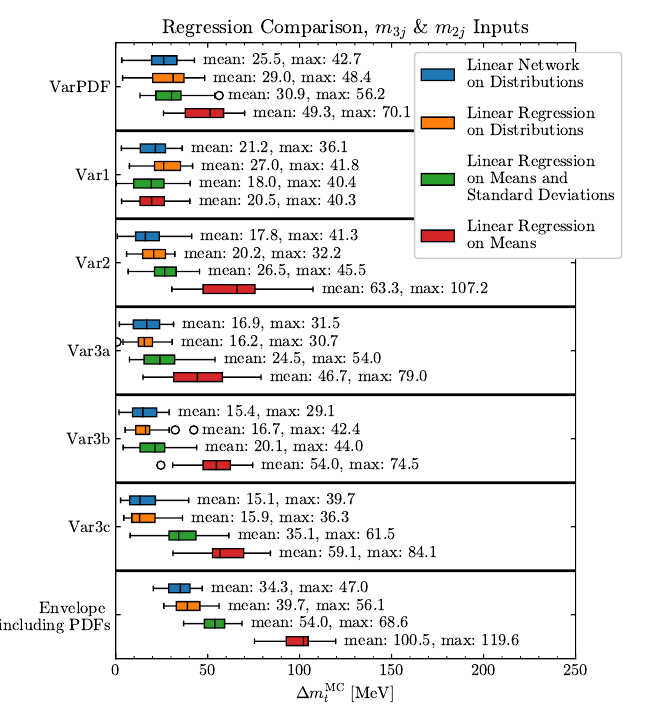
Figure 9. Uncertainties on the top mass fit within each group of variations in the A14 set of tunes for the OLS regressions, compared to the best linear